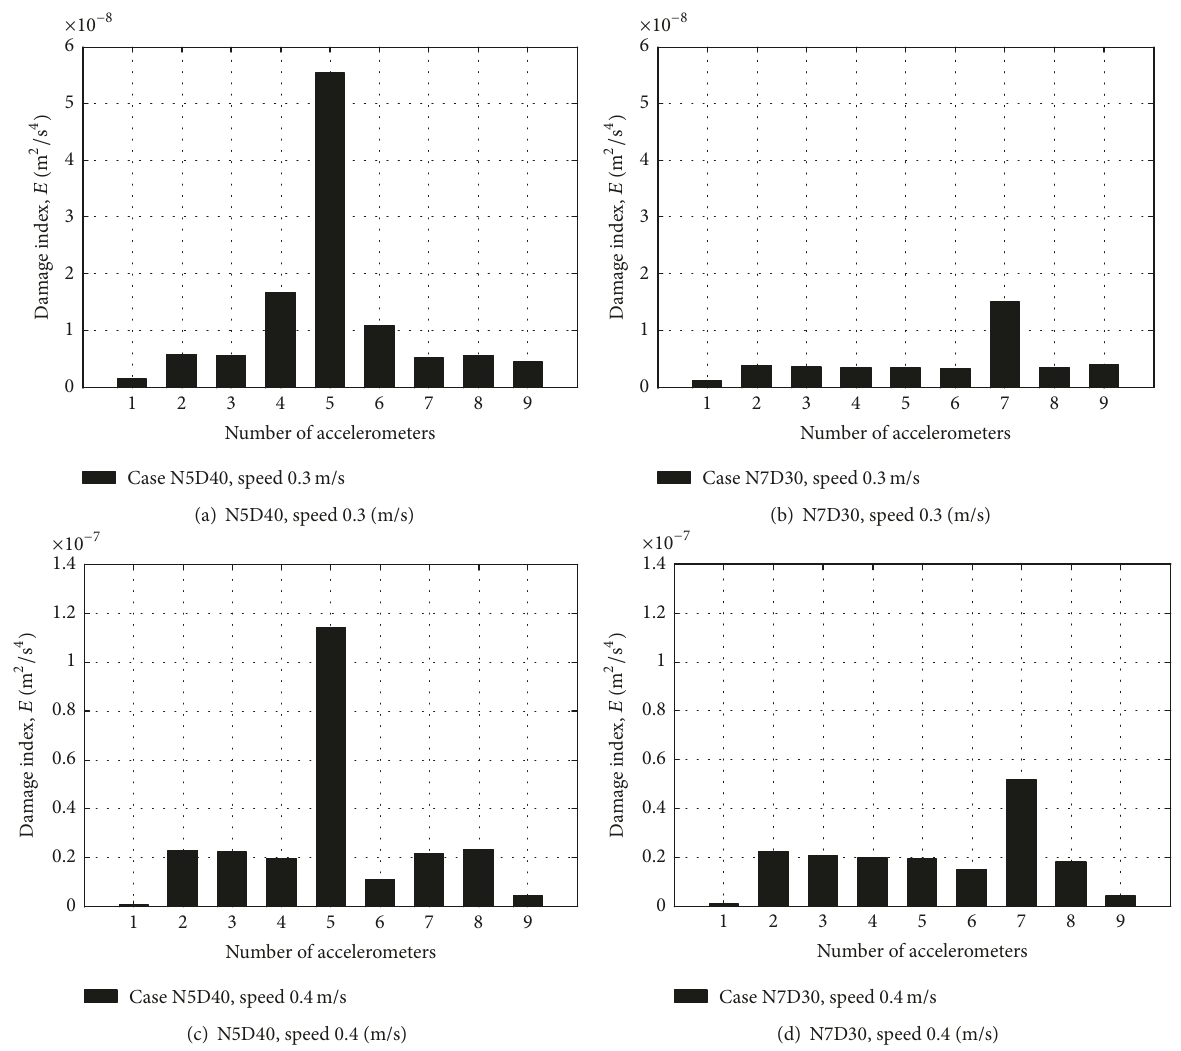
Figure 16: Scalar values of damage index 𝐸 𝑛 for all accelerometers at different locations and load moving velocities, as obtained from the numerical model: (a) case N5D40 (velocity = 0.3 m/s), (b) case N7D30 (velocity = 0.3 m/s), (c) case N5D40 (velocity = 0.4m/s), and (d) case N7D30 (velocity =